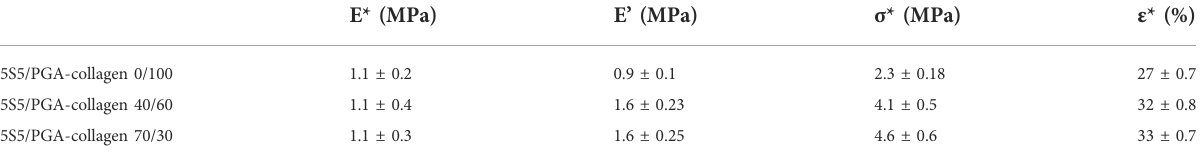
TABLE 2 Elastic modulus (E*), collapse modulus (E 9 ), collapse strength ( σ *) and strain ( ε